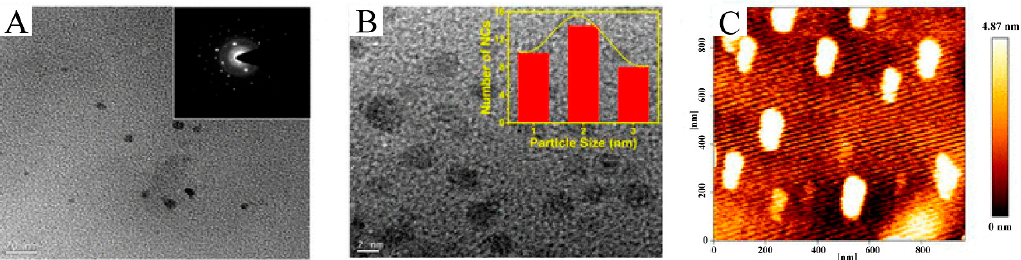
Figure 10. Morphology characterization of CUR-AuNCs: ( A ) TEM of CUR-AuNCs; the inset image is SAED pattern. ( B ) HR-TEM; arrow indicates the collections of atoms to form a cluster. ( C ) Bio-AFM height image of CUR-AuNCs. Adapted from reference [284]. Copyright 2018 American Chemical Society.